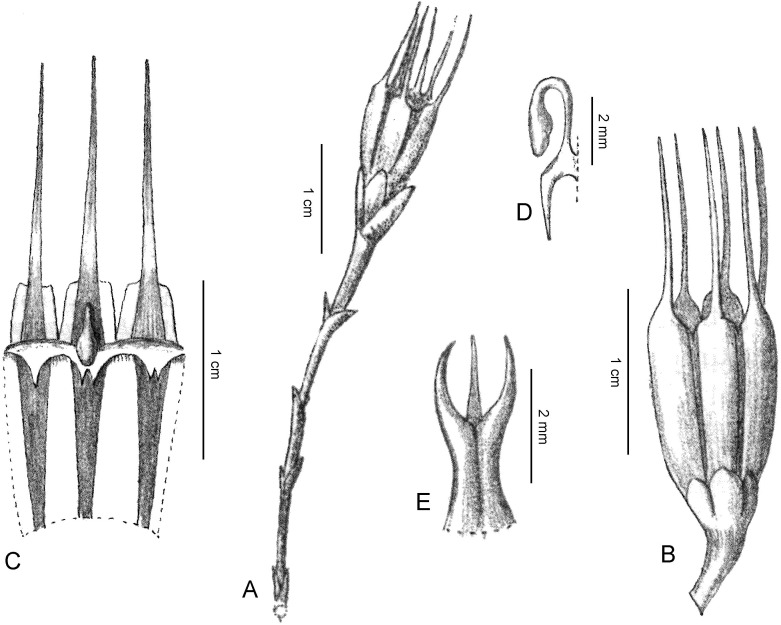
Oxygyne triandra.(A) Habit; (B) flower; (C) perianth, part, opened, inner surface; (D) stamen and annulus in section, side view; (E) style-stigma. From Schlechter (1906), drawn by Joseph Pohl (1864–1939).